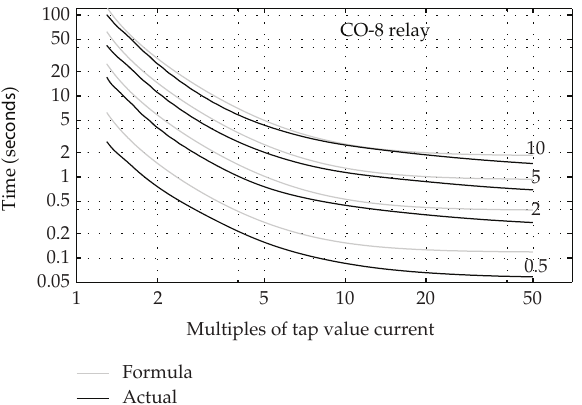
Figure 1: The actual characteristic curves and the curves fitted by (cid:3) 2.6 (cid:4) for the CO-8 relay.